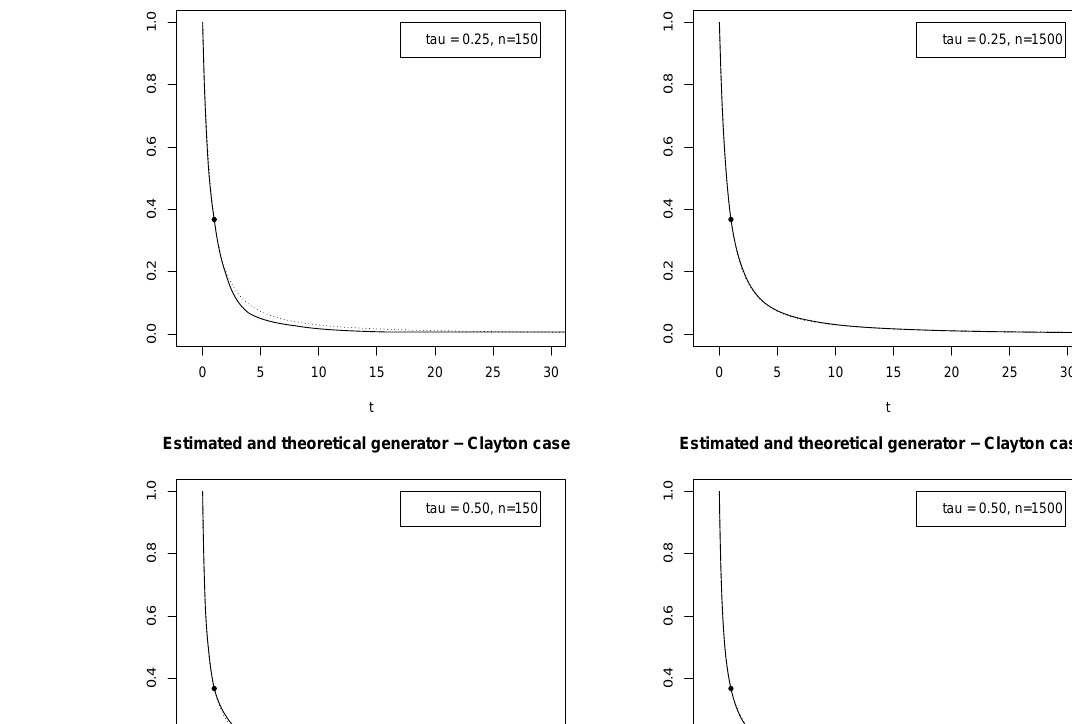
,φ , e − 1 ) (black 0 0 ) = (1